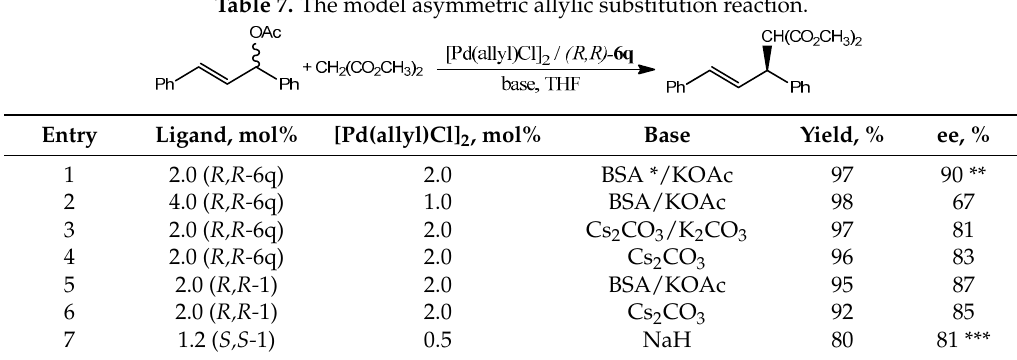
Table 7. The model asymmetric allylic substitution reaction.